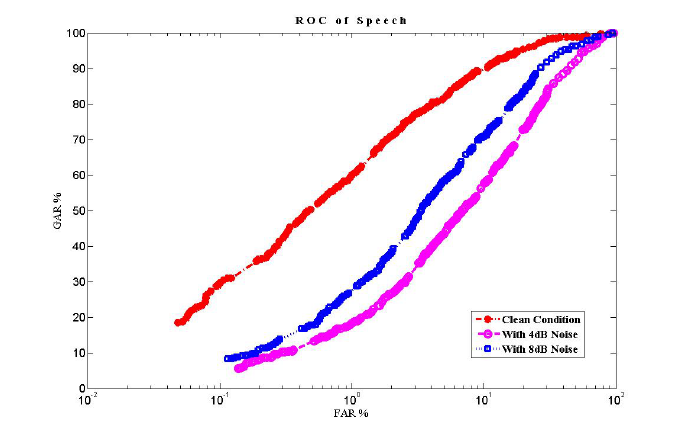
Figure 8. ROC for speech samples (clean and